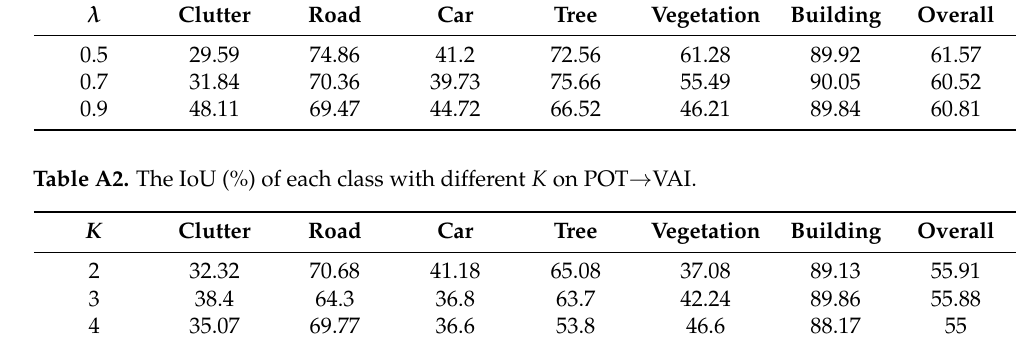
Table A1. The IoU (%) of each class with different pseudo-label thresholds λ on POT → VAI. λ